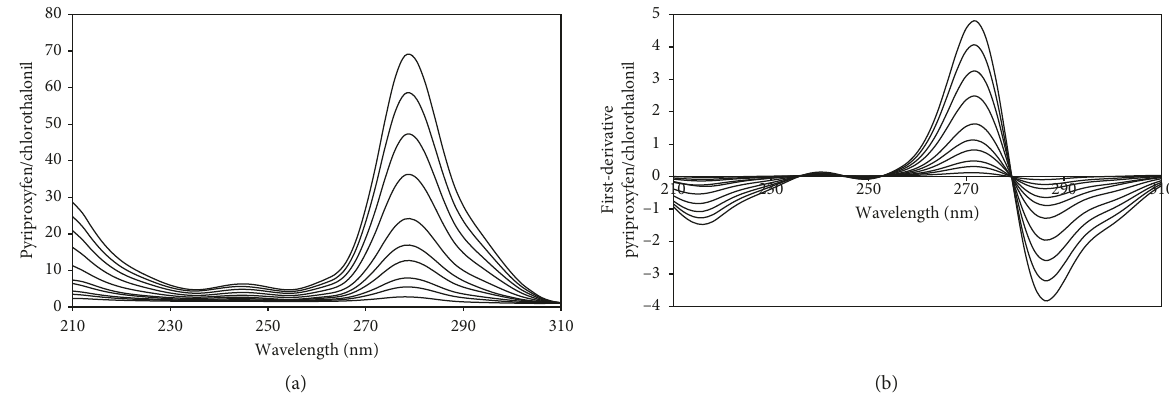
Figure 9: Ratio spectra (a) and first derivative ratio spectra (b) of pyriproxyfen (1, 2, 3, 5, 7, 10, 15, 20, 25, and 30 μ g · mL − 1 ) when 1.5 μ g · mL − 1 of chlorothalonil was used as the divisor in methanol ( ∆ λ � 4nm).